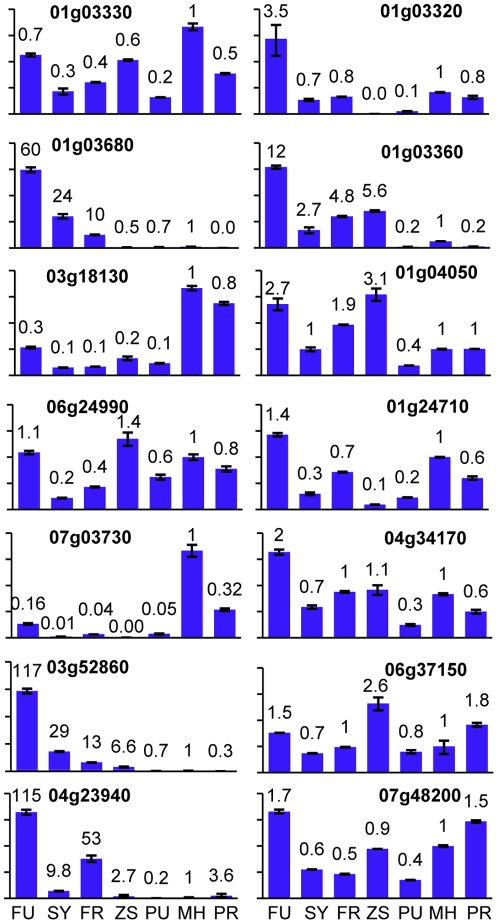
Different effects of OsHDT1 in hybrid and parent.A selection of 14 genes was analyzed by quantitative RT-PCR in the indicated genotypes: PU, OsHDT1-over-expression in MH63; MH, MH63; PR, OsHDT1 RNAi in MH63; FU, OsHDT1-over-expression in SY63; SY, SY63; FR, OsHDT1 RNAi in SY63. Left panels: genes showing nonadditive expression, right panels, genes showing additive expression in the hybrid.